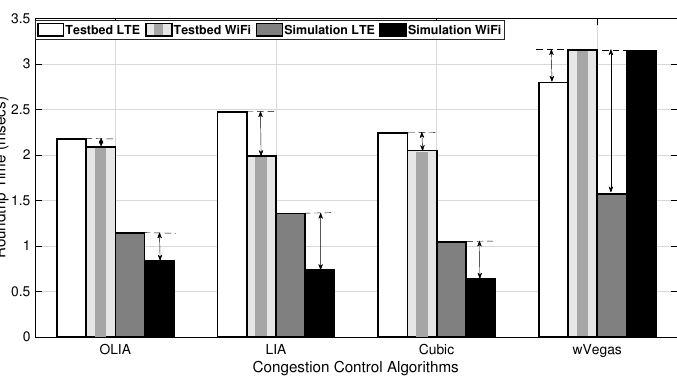
Figure 11. Setup 1 uplink MPTCP RTT for 20 MB flows.